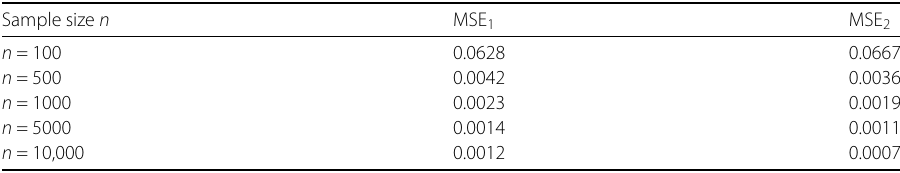
Table 1 The MSEs of Nadaraya–Watson estimator (MSE 1 ) and variable bandwidth local M-estimator (MSE 2 ) for drift function μ ( · ) Sample size